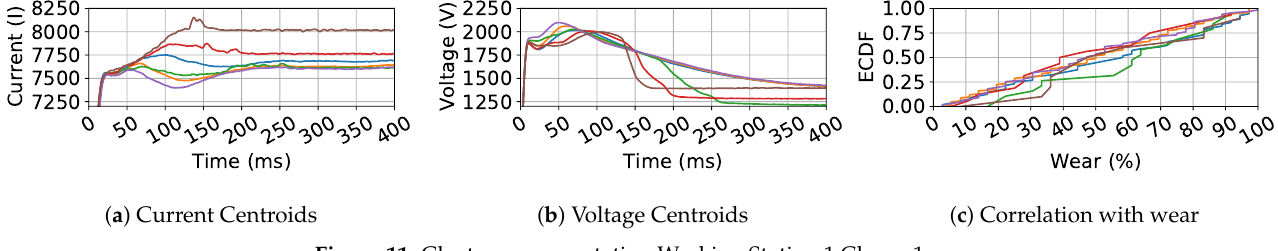
Figure 11. Clusters representation Working Station 1 Clamp 1 ws b